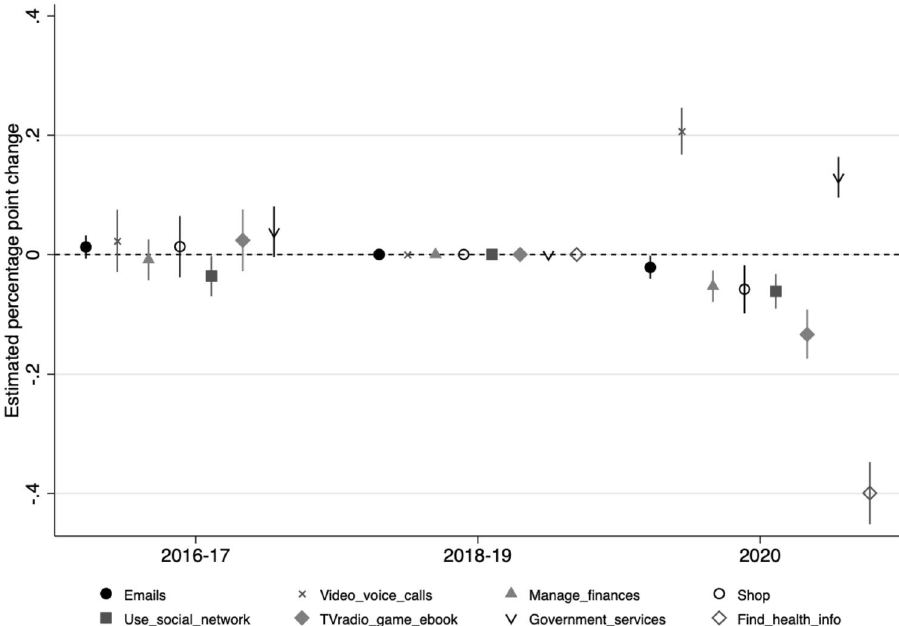
Figure 4. Within-individual changes from 2018/2019 in types of Internet use. Estimates are from individual fixed-effects regressions, which include controls for the following observed time-varying covariates: age, partnership and employment status, perceived financial difficulties, self-reported health, depressive symptomology, loneliness, levels of positive and negative support from partner, and contact with others. Not shown is the estimate for reading news, newspaper, or blog websites-this was not significantly different from zero, suggesting that this type of Internet use did not change during the pandemic from the 2018/19 period. The full regression output is in Supplementary Table S7 ( n = 4831 unique individuals for types of Internet use, i.e., excluding less than monthly